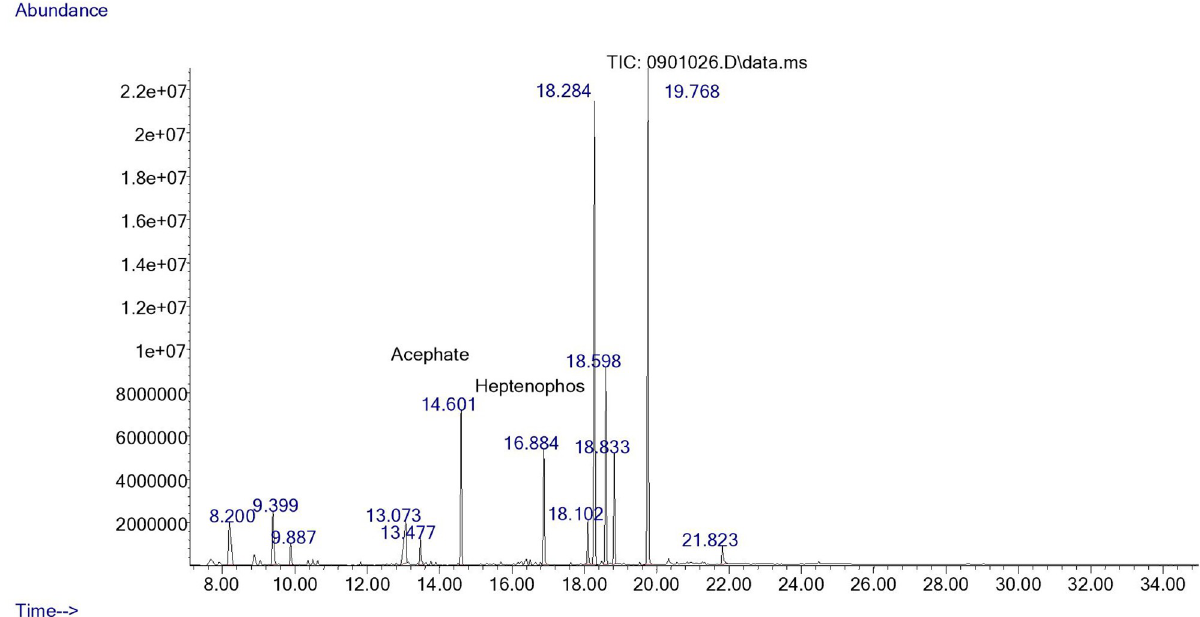
Fig 3. Chromatogram of heptenophos and acephate in Kale.